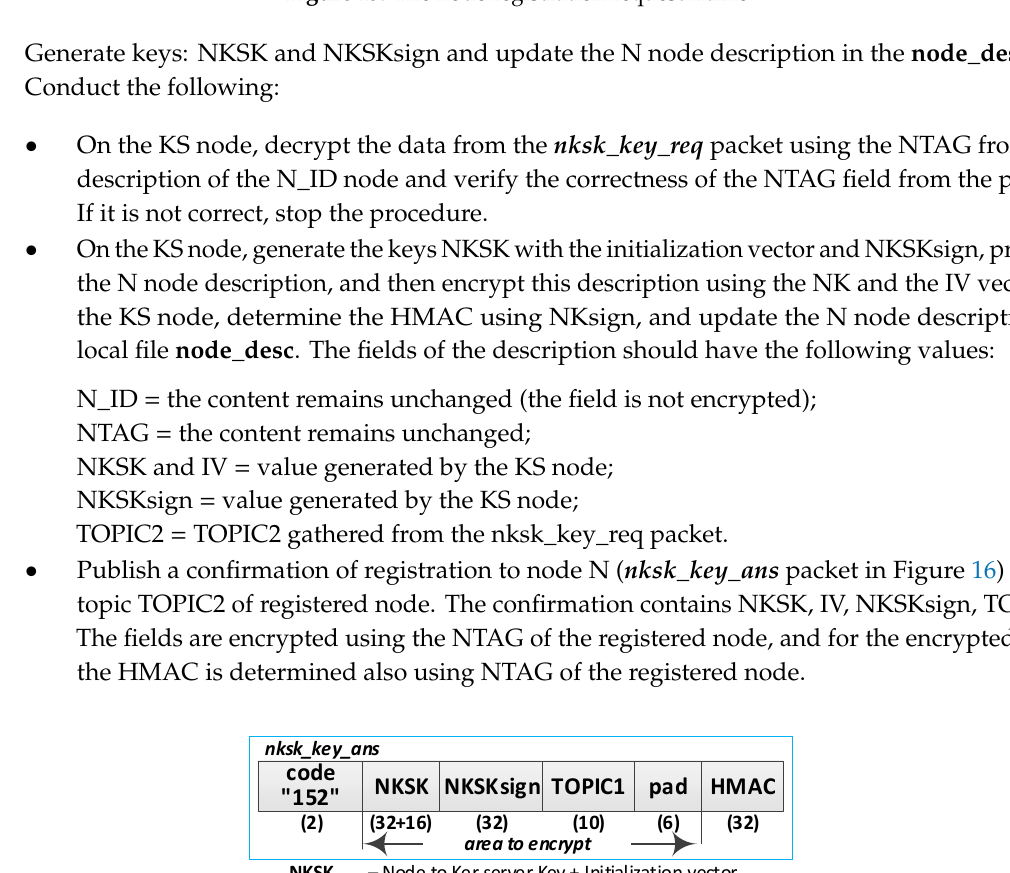
Figure 16. The confirmation frame for node registration.